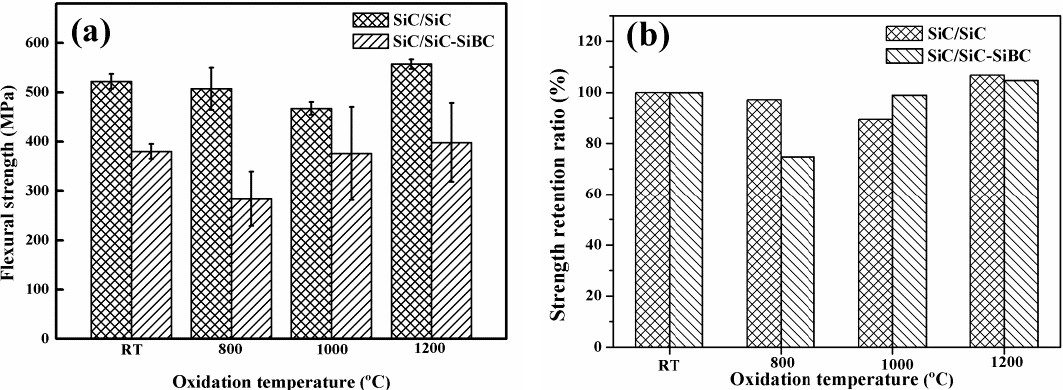
Figure 5. ( a ) The flexural strength and ( b ) the residual retention ratios of both composites after oxidation at different temperatures.